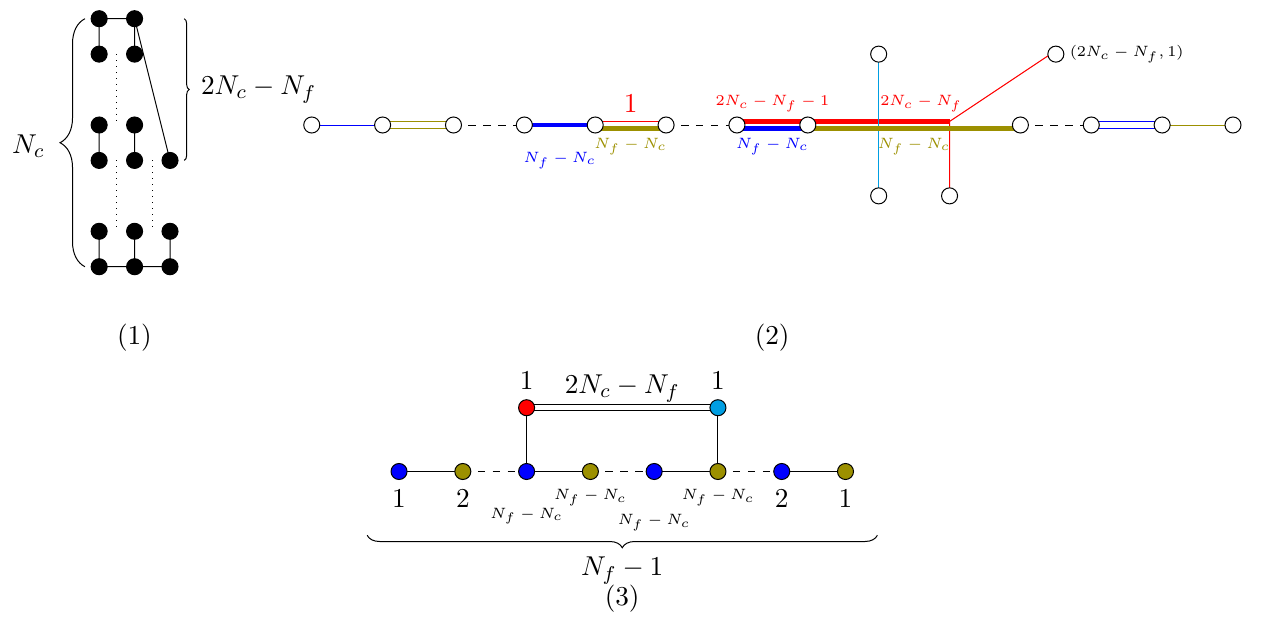
Figure 14 . (1) Toric Diagram representing SQCD with N c < N f < 2 N c Web indicating the Baryonic cone of the Higgs Branch (3) magnetic Quiver whose 3d Coulomb Branch is the Baryonic cone of the Higgs Branch of our